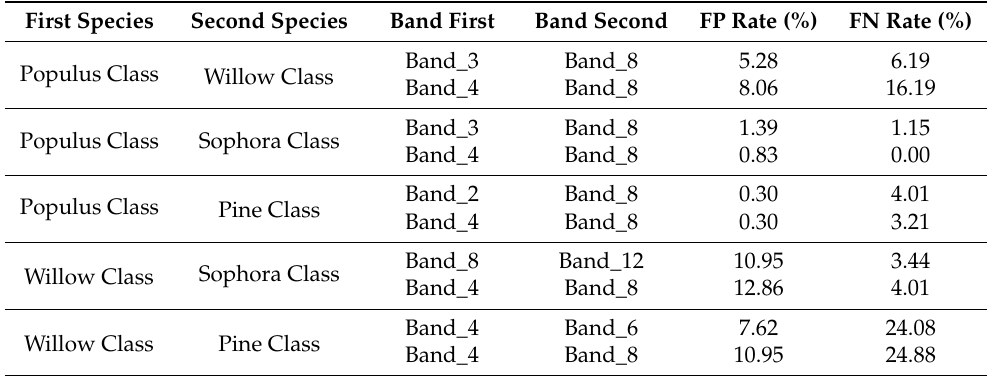
Table 4. Comparison of band combinations.